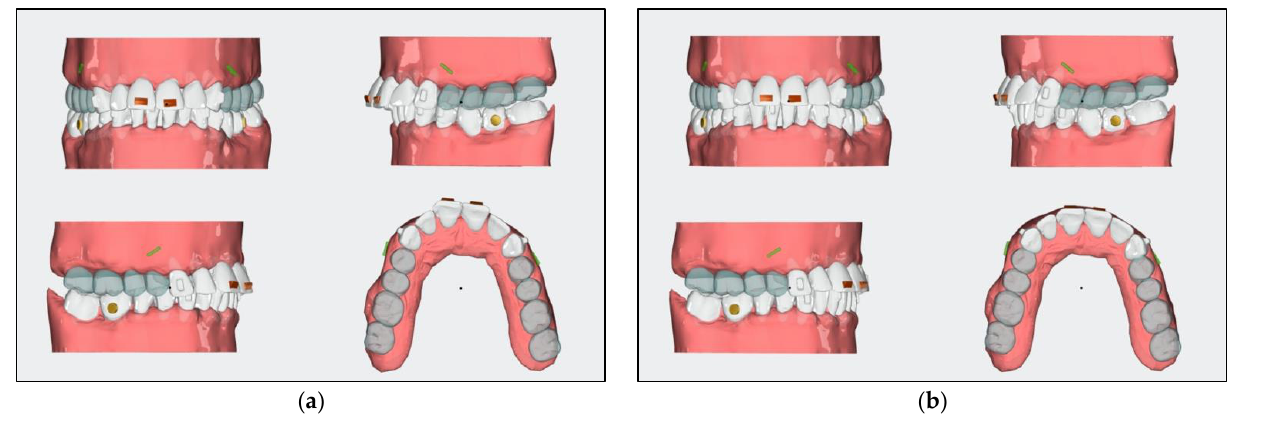
Figure 14. Digital planning: ( a ) pontics of teeth 14, 15, 16, 17, 24, 25, 26, and 27 in the beginning of orthodontic treatment; ( b ) pontics of teeth 14, 15, 16, 17, 24, 25, 26, and 27 at the end of orthodontic treatment.